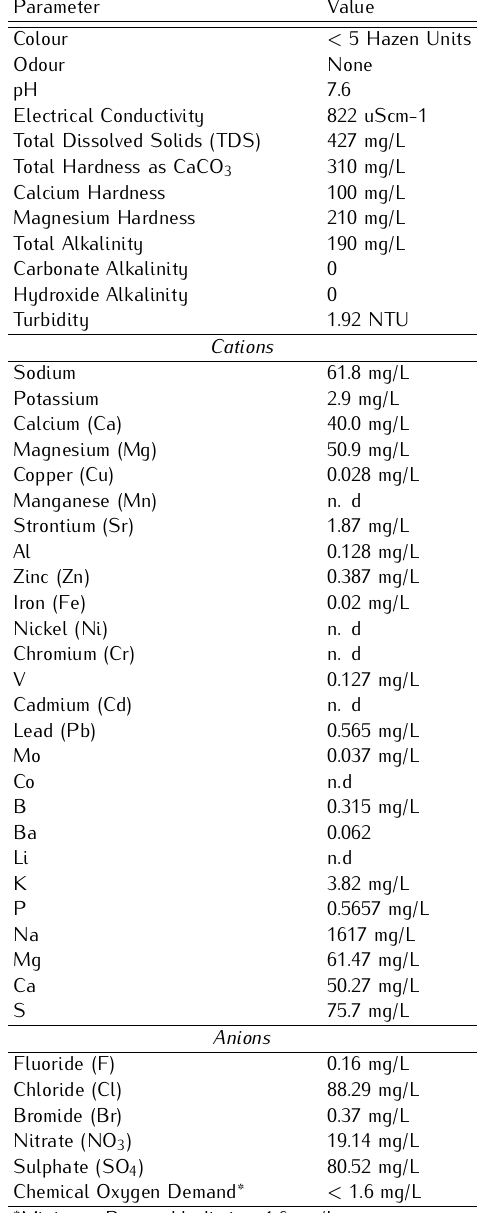
Table 5. Analysis of citizen’s well water. Table 6. Analysis of water from acid evaporation pond, soil sample